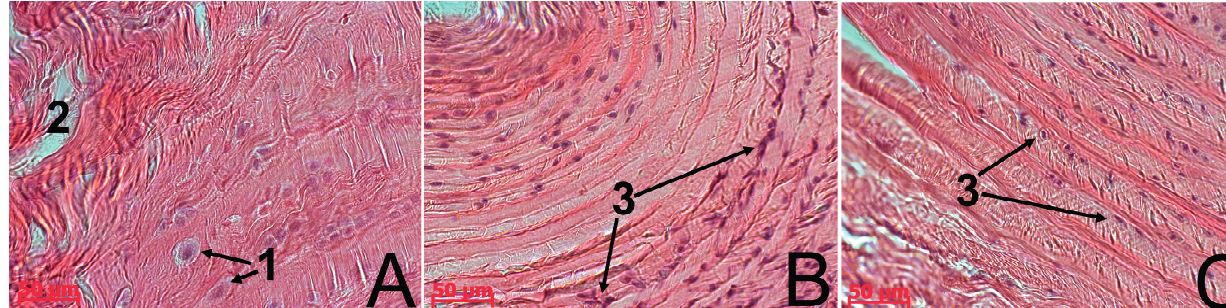
Figure 3. The IVD Co6–Co7 in rats. In the control group of animals ( A ), large chondrocyte-like cells with spherical nuclei surrounded by a wide rim of cytoplasm (1) were detected near the clefts (2). In the case of native MSC administration ( B ) as well as the cryopreserved one ( C ), the AF cell population was represented by small fibrochondrocyte-like cells with ovoid nuclei